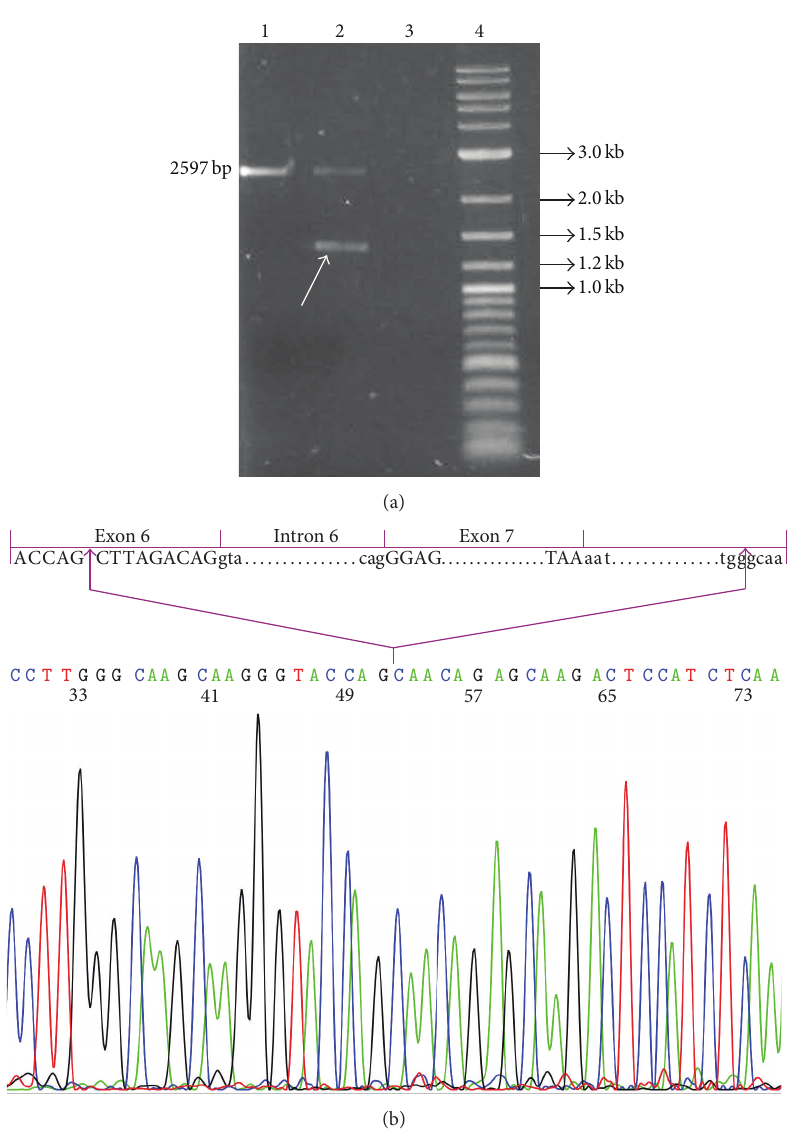
Figure 2: (a) Results of the long-range PCR assay in the proband with exon 7 deletion (lane 2) and healthy control (lane 1). Arrow indicates the aberrant (shorter) product. Lane 4, 10kb ladder. (b) Breakpoint analysis and schematic figure of GLA gene exon 7 deletion. Sequence analysis showed a 1182bp deletion with its 5 󸀠 end located within exon 6 and its 3 󸀠 end located 612bp downstream of exon